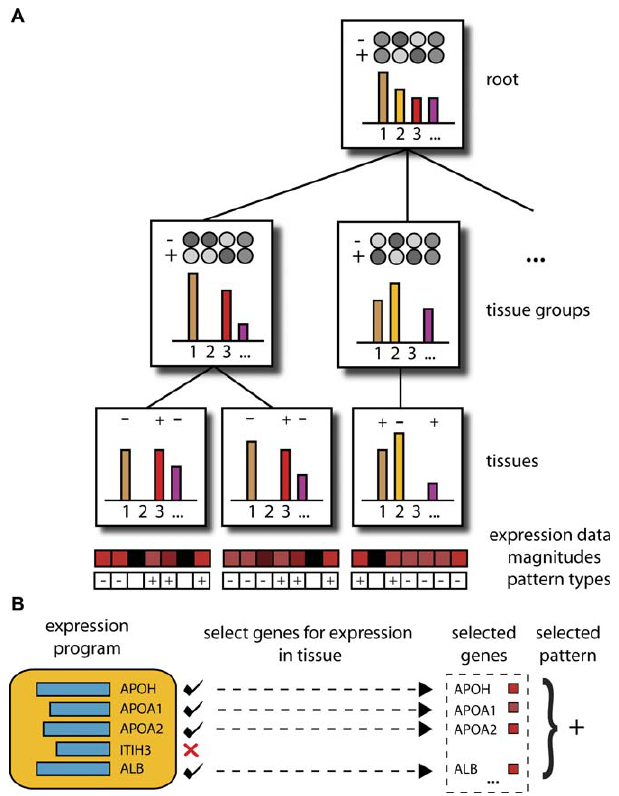
Figure 3. Overview of the GeneProgram Probability Model, Which Is Based on Hierarchical Dirichlet Process Mixture Models (A) The model consists of a three-level hierarchy of Dirichlet Processes. Each node describes a weighted mixture of expression programs (each colored bar represents a different program; heights of bars ¼ mixture weights). The distributions at each level are constructed on the basis of the parent mixtures above. Tissue group and root level nodes maintain distributions over usage modifiers (shaded circles above bars, darker circles ¼ more probable), which are variables that alter the manner in which each tissue uses an expression program. In this example, there are two possible values for usage modifier variables ( þ or (cid:2) ), corresponding to gene induction or repression; more complex patterns such as temporal dynamics can be captured by using more values. Tissues are at the leaves of the hierarchy, and choose particular values for usage modifier variables. The observed gene expression in each tissue is characterized by a vector of discretized expression magnitudes (first row of small shaded squares below each tissue) and pattern types (second row of squares with þ / (cid:2) designations below each tissue). (B) Example of a gene expression program, which represents a set of genes that are likely to behave coordinately in particular tissues that use the program. On the left is a simple program containing five genes (colored bars ¼ expression frequencies). A tissue probabilistically chooses a set of genes from a program, and also a setting for its usage modifier variable. Note that usage is consistent across a program for a particular tissue, which facilitates biological interpretation.